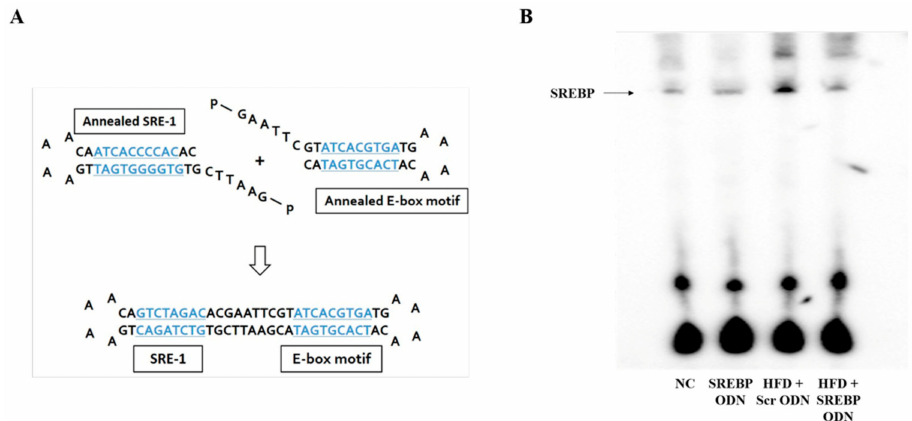
Figure 1. Construction of sterol regulatory element binding protein (SREBP) decoy ODN. ( A ) The target sites for SREBP were selected via the sequential overlap-simulation of secondary structures using the S-Fold program. SREBP ODN ligates the annealed SRE-1 and annealed E-box motif